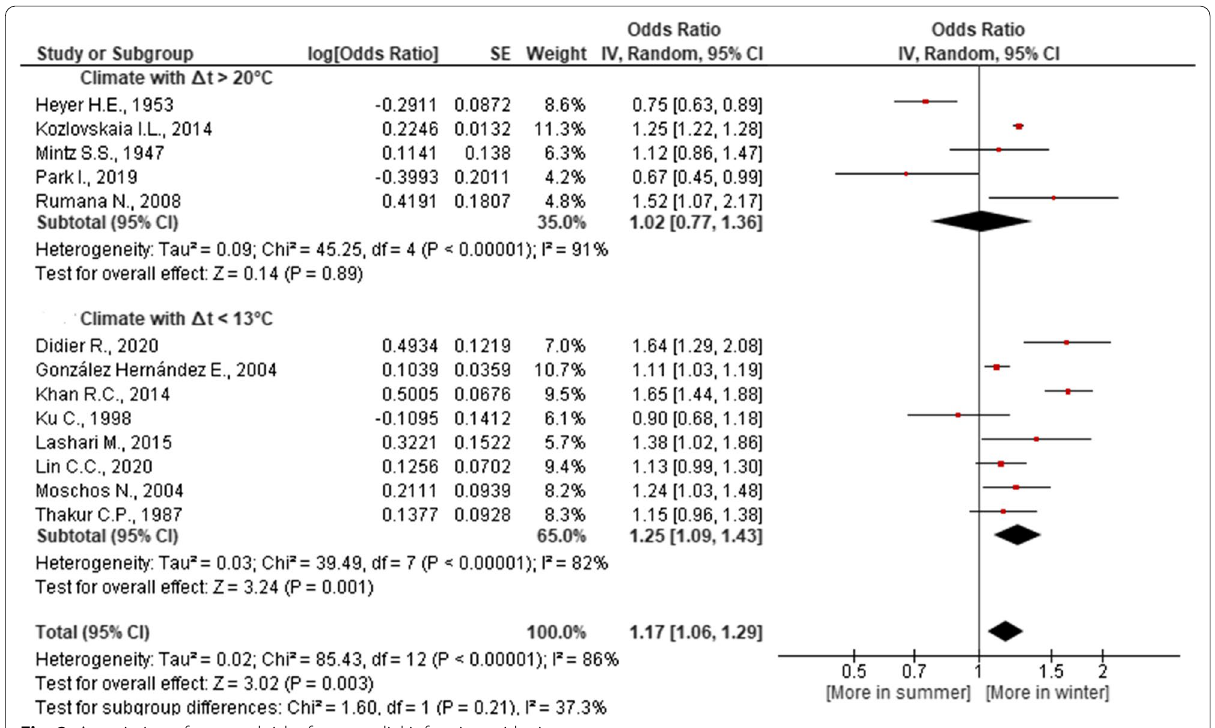
Fig. 2 Association of seasonal risk of myocardial infarction with air